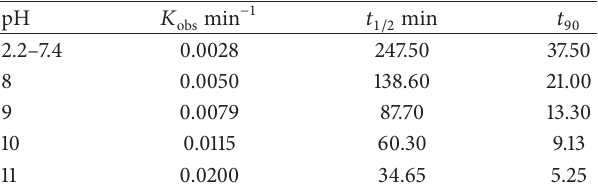
Table 3: 𝐾 , 𝑡 1/2 , and 𝑡 90 values for the degradation of colistin obs sulphate at room temperature in different pH values.